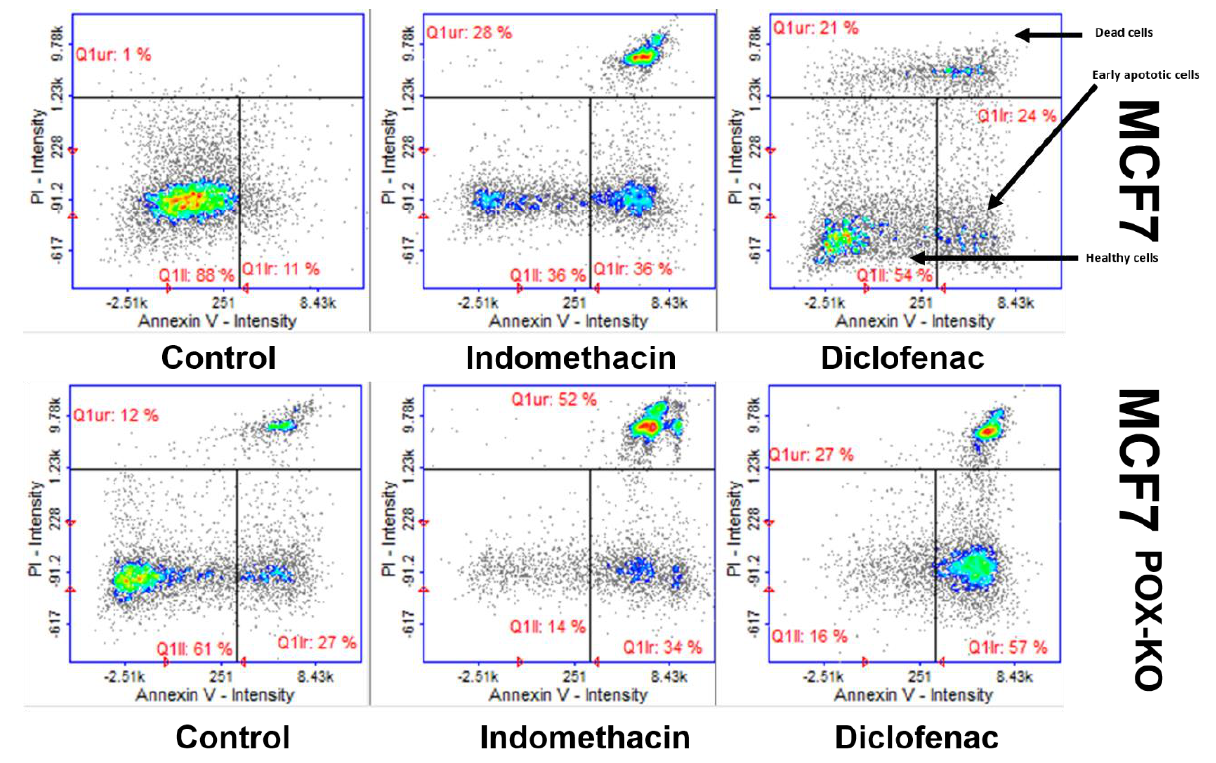
Figure 2. Cytometric assay of apoptosis in MCF-7 and MCF7 POX-KO cells. After 12 h of incubation with 0.5 mM indomethacin and 0.375 mM diclofenac, cells were stained with fluorescent dyes using annexin V and propidium Iodide.